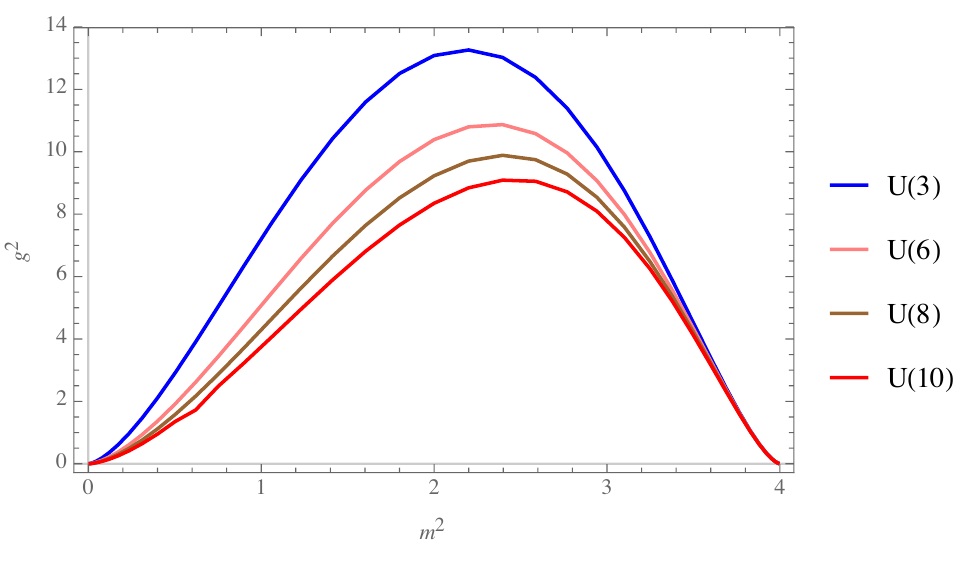
Figure 11 . Upper bounds on the coupling to a single symmetric tensor bound state.